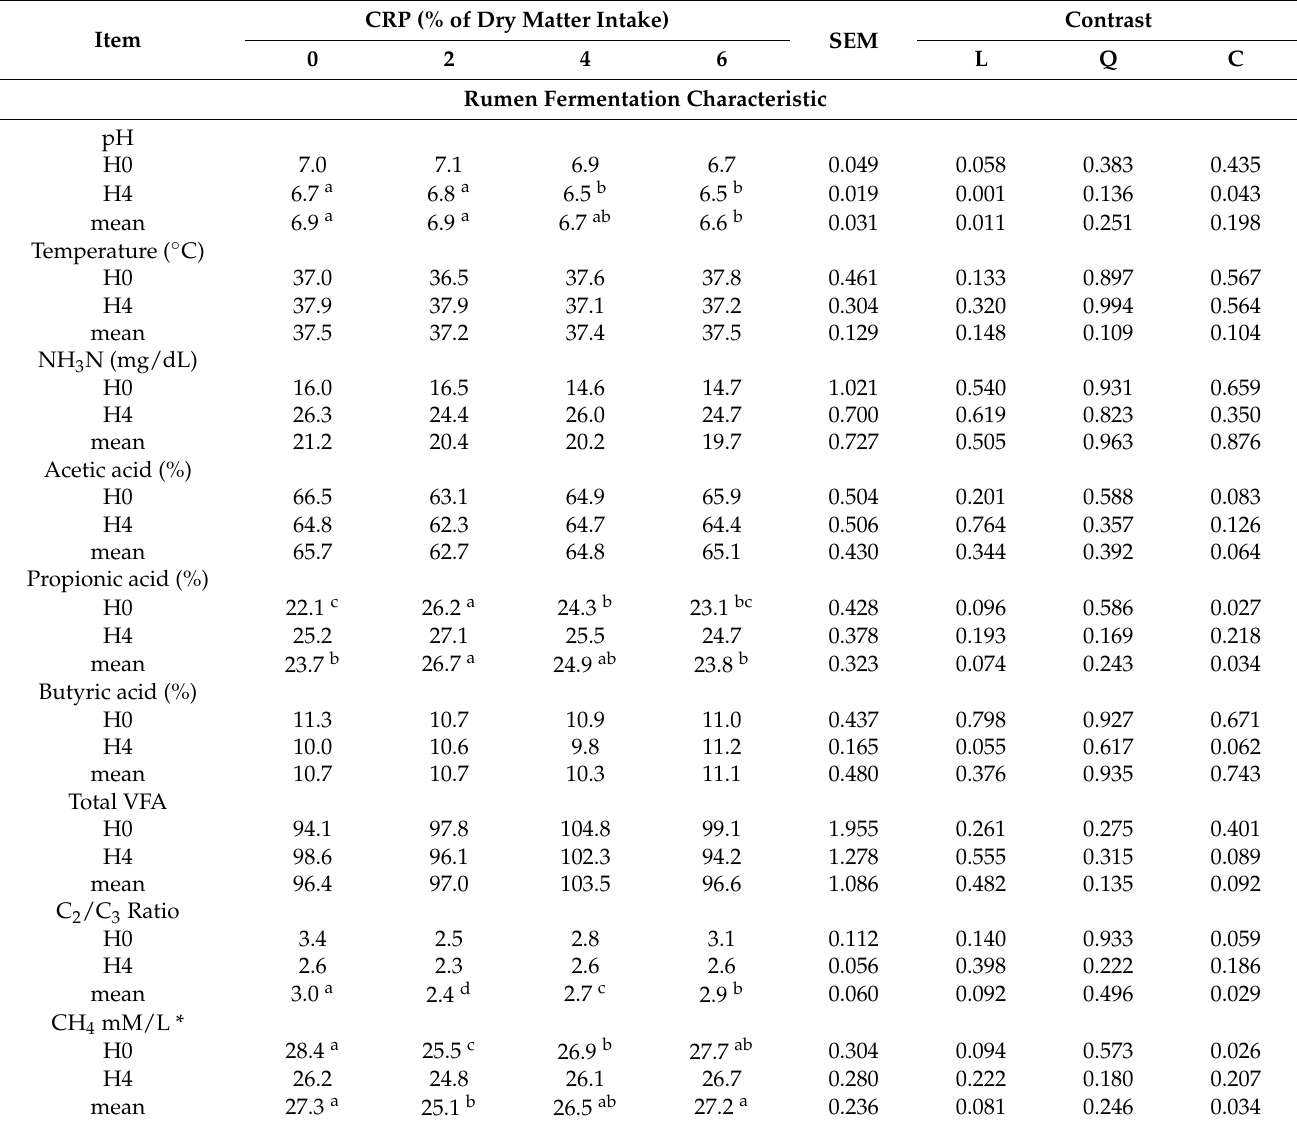
Table 3. Effect of chaya leaf and rambutan peel pellet (CRP) on rumen